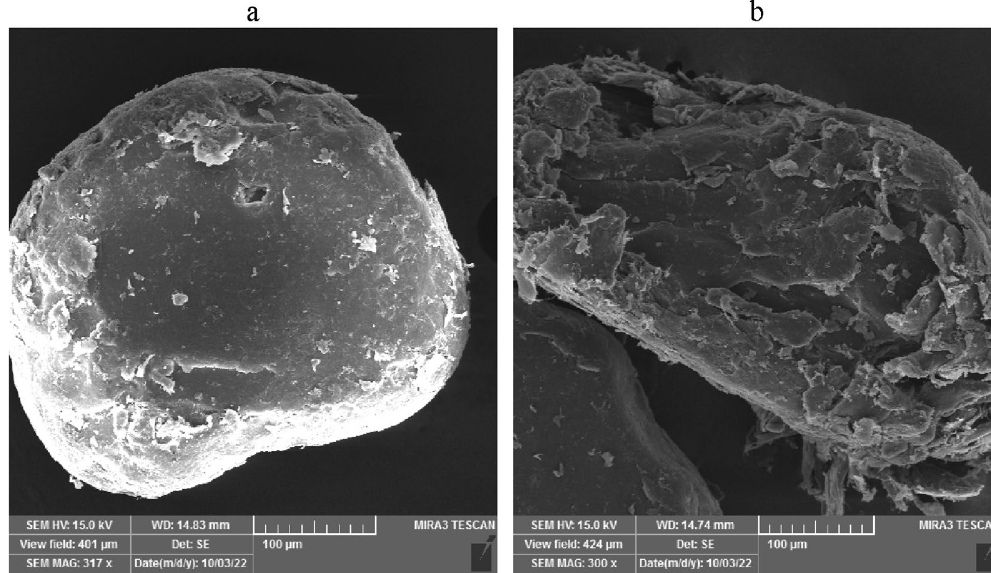
Figure 10. The SEM images of the nanocomposites: ( a ) without the IL in formation, ( b ) with the IL in formation.